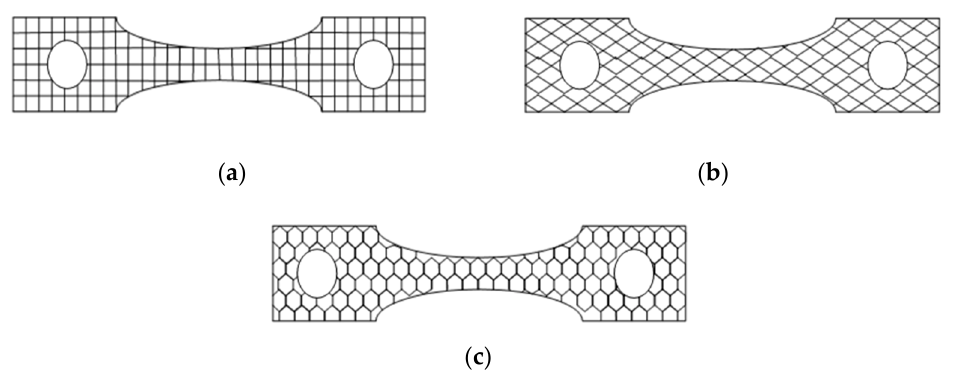
Figure 2. The adopted infill patterns: ( a ) linear, ( b ) diamond, ( c ) hexagonal.